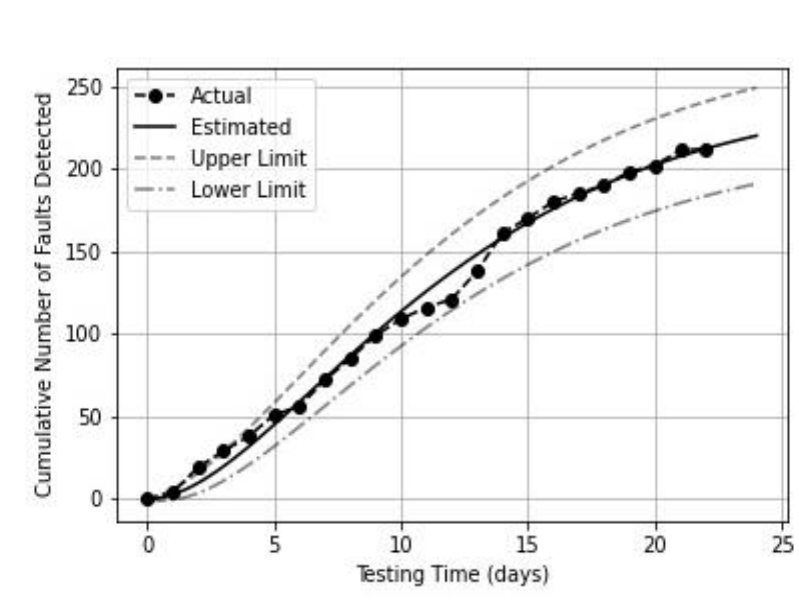
Figure 2. Estimated delayed S-shaped software reliability model with 95% confidence